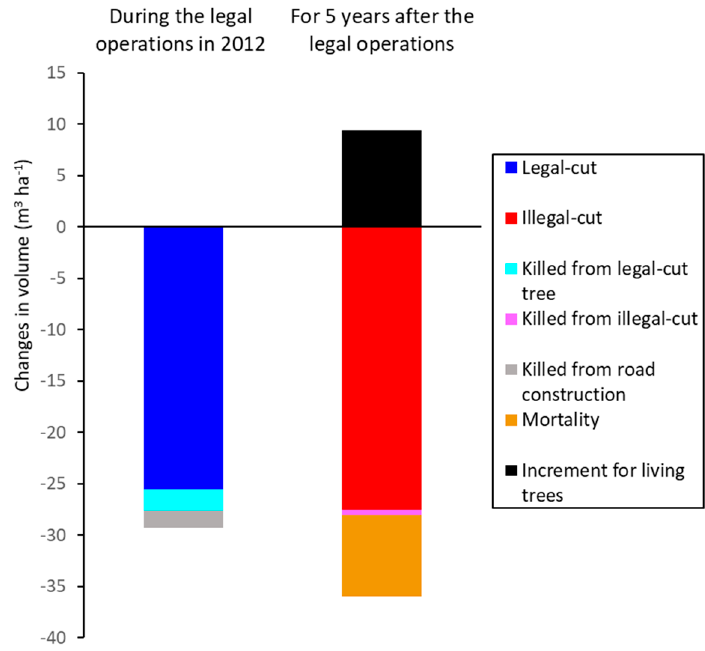
Figure 4. Changes in the volume (m 3 ha − 1 ) of trees with a DBH ≥ 20 cm for each component of stand dynamics during the legal logging operations in 2012 and during the 5-year post-harvest period (2012–2017) in Compartment 93, South Zamaye Reserved Forest, Bago Yoma, Myanmar.